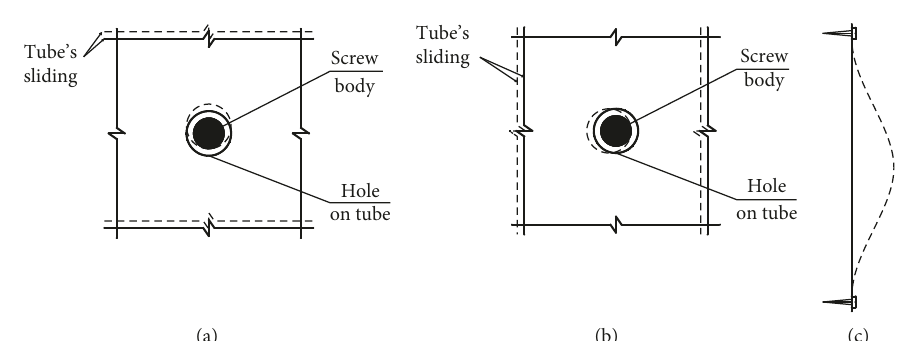
Figure 7: P- Δ curves.